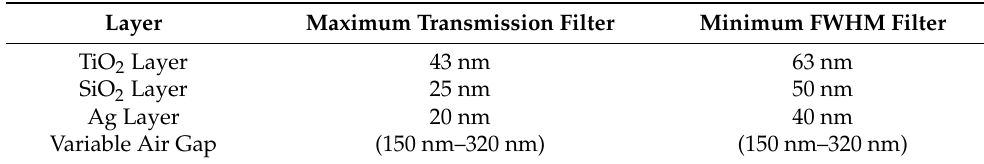
Table 1. Optimized layers’ thicknesses for filters structure targeting maximum transmission and minimum FWHM.